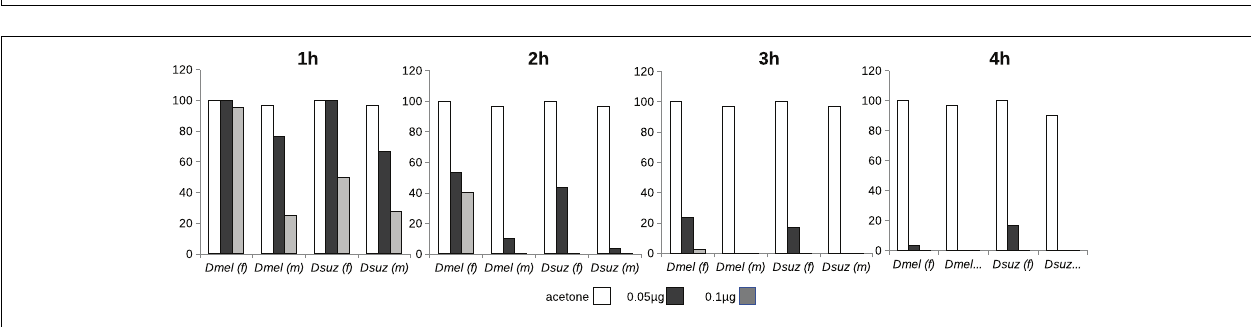
FIGURE 3 | Groups of flies were exposed to three different amounts of chlorpyrifos for 4 h. Survival was recorded every hour. At least 30 flies were tested in each experiment.